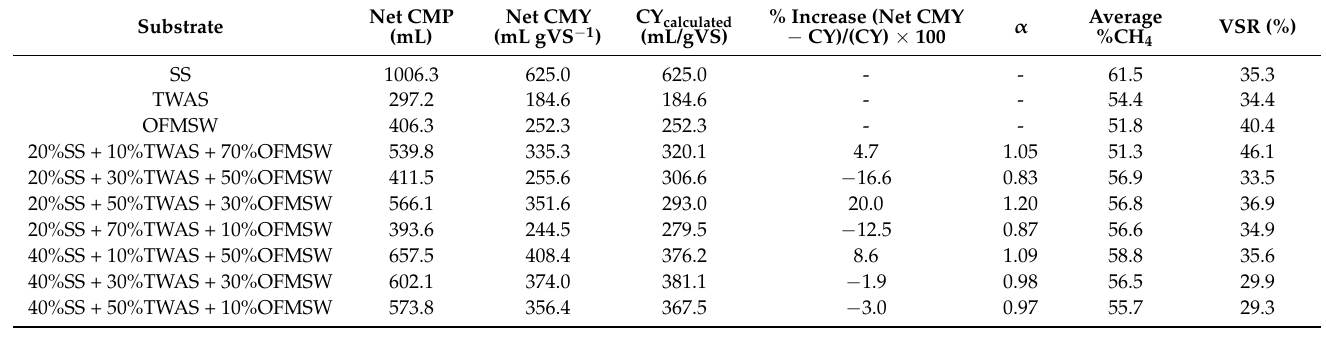
Table 3. BMP test results in both mono-digestion and co-digestion experiments.